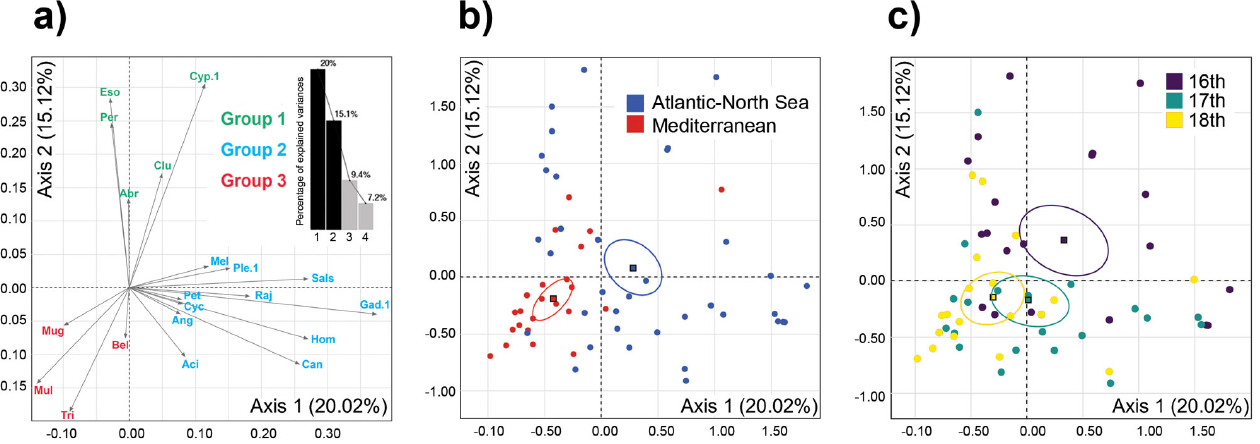
Fig. 5 . Distribution of selected taxa. (a) Principal component analysis (PCA) of the selected taxa represented in the paintings, showing that taxa are distributed in the paintings according to three distinct groups. Mul = Mullus , Mug = Mugilidae, Tri = Triglidae, Bel = Belone belone , Aci = Acipenser sturio , Ang = Anguilla anguilla , Raj = Rajidae, Ple.1 = Pleuronectidae, Cyc = Cyclopterus lumpus , Can = Cancer pagurus , Hom = Homarus gammarus , Pet = Petromyzon marinus , Gad.1 = Gadus morhua , Sals = Salmo salar , Mel = Melanogrammus aeglefinus , Clu = Clupea harengus , Abr = Abramis brama , Eso = Esox lucius , Per = Perca fluviatilis , Cyp.1 = Cyprinus carpio . (b) PCA across the two regions: each point corresponds to a painting, colored according to its geographical origin. (c) PCA across the three periods: each point corresponds to a painting, colored according to its period. For each PCA, only the first two dimensions are shown. The segmentation in space and time was given by confidence ellipses around barycenters at the 95%